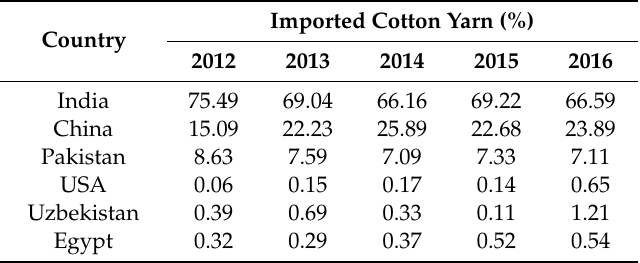
Table A2. Percentage of imported cotton yarn from di ff erent countries [68].